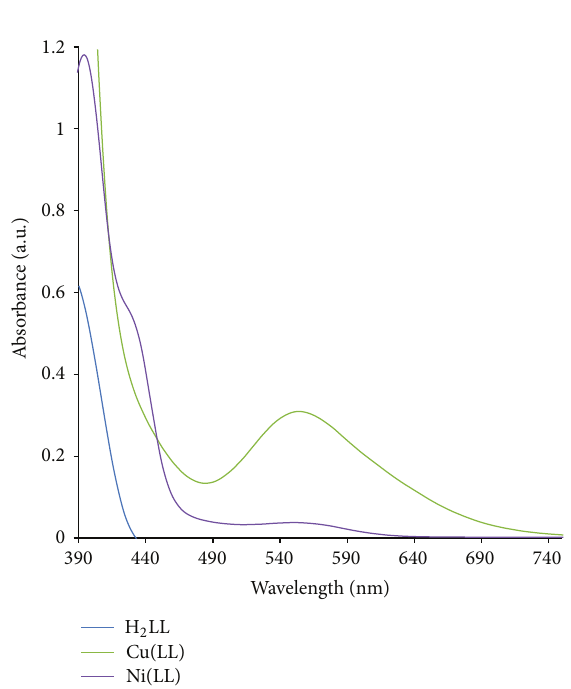
Figure 3: Electronic absorption spectra of H 2 LL, Cu(II), and Ni(II) complexes in